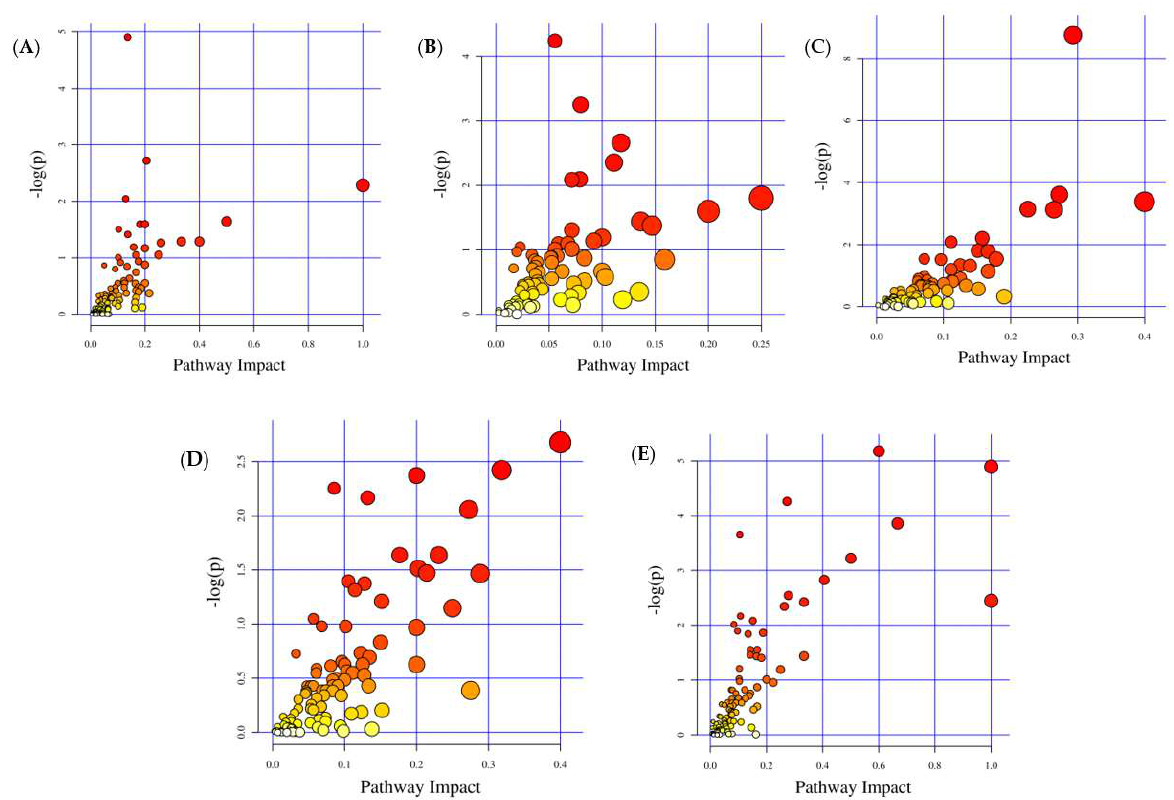
Figure 7. Different pathways analyses are shown as follows: ( A ) NCG vs. FG; ( B ) HBG vs. FG; ( C ) HB-1 vs. FG; ( D ) HB-2 vs. FG; ( E ) HB-3 vs. FG.